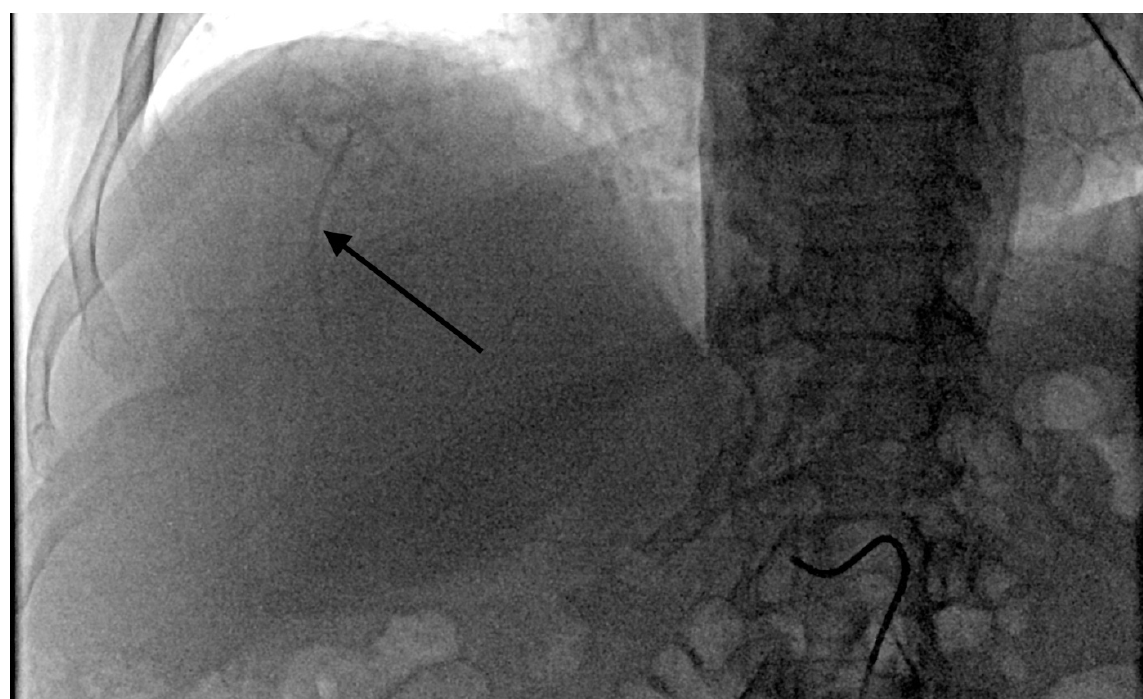
Figure 4. Temporary stasis at the level of segmental vessels of right hepatic artery (arrow).